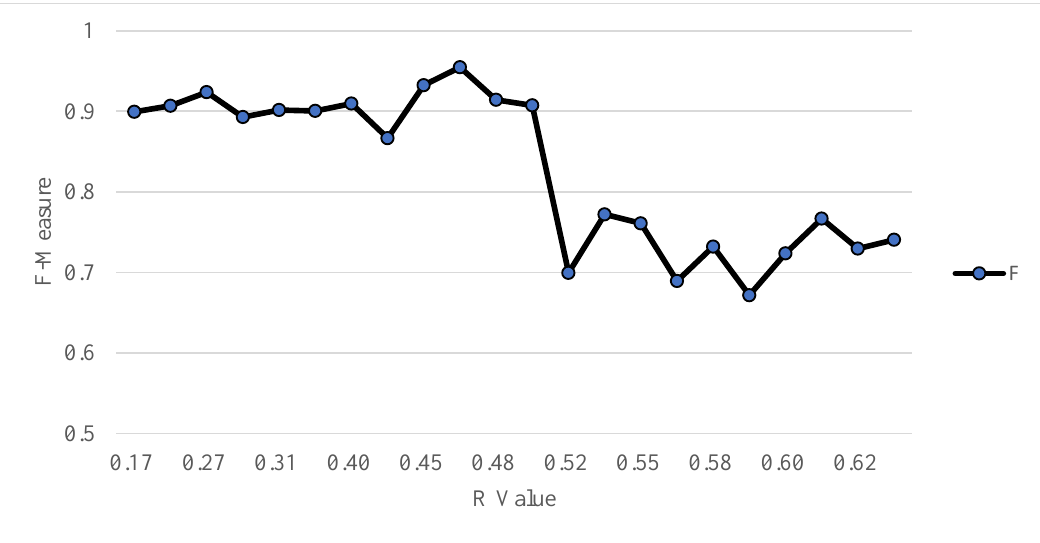
Figure 13. Relationship between shadow/nonshadow contrast ( R ) and F value.